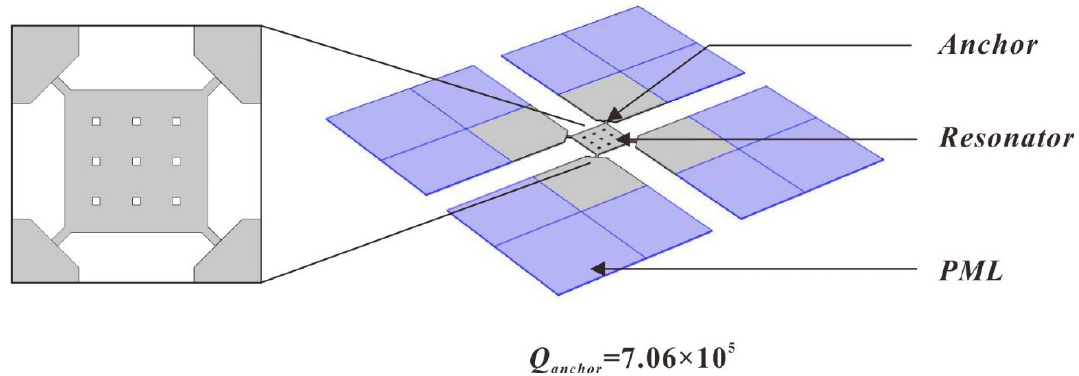
Figure 2. Simulation model of anchor loss using the perfectly matched layer (PML) method in COMSOL.